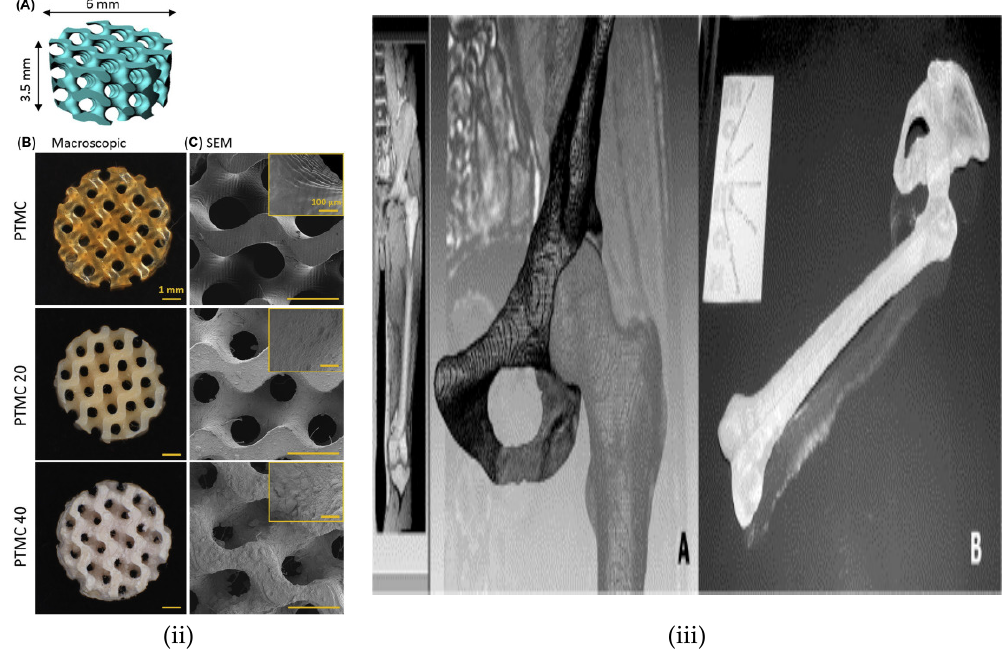
Figure 6. ( i ) Schematic diagram of stereolithography (SLA) printer setup [63]. ( ii ) ( A ) Proposed 3D model, ( B ) macroscopic view of SLA ‐ printed scaffolds containing PTMC only and PTMC with two varying ratios of HA respectively and ( C ) representative SEM images of the SLA ‐ printed scaffolds [64]. ( iii ) A rapid prototype generation starting from MR images, the triangulated mesh is generated. ( A ) The MR image. ( B ) SLA reconstruction of the hip joint [65]. Reprinted with permission from Ref. [65]. Copyright 2005, Elsevier.